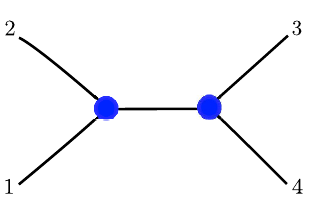
σ ( x ) σ (0) = c σ . We integrate x 2 h i